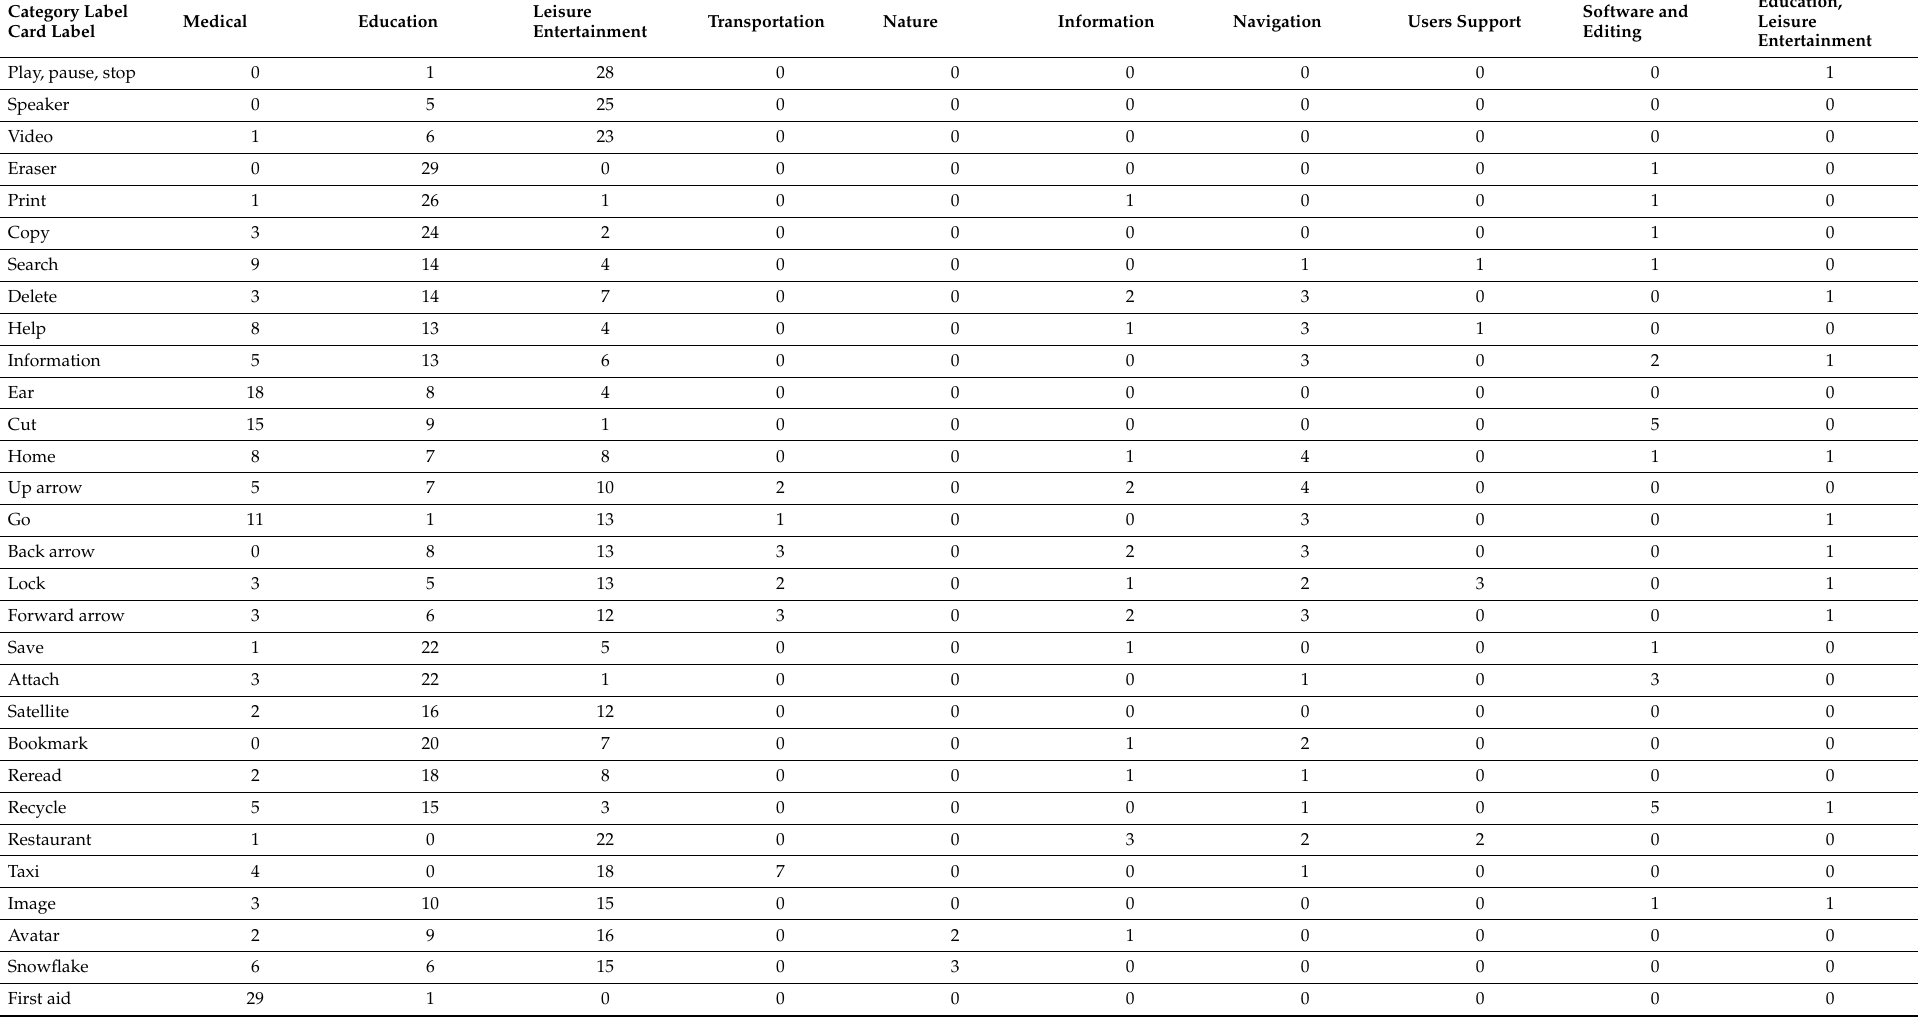
Table A2. The co-occurrence of the card in a